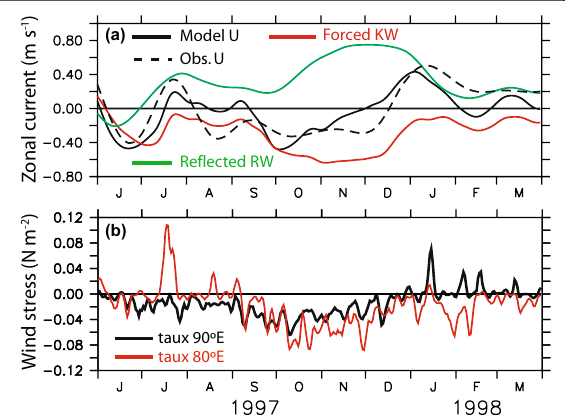
Fig. 3 Time series of a zonal current anomaly at box-C for June 1997–March 1998 from the OSCAR (black-dashed), the total model solution (black), eastern-boundary-generated Rossby waves (green), and the wind-forced Kelvin wave (red), b zonal wind stress at 90 °E (black) and that at 80 °E